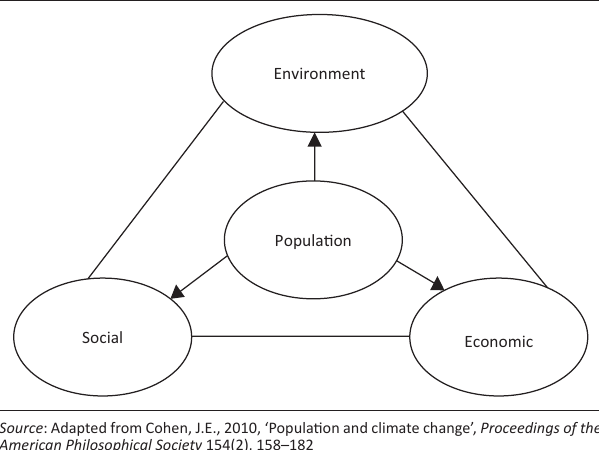
FIGURE 1: Interactions between human population and sustainable development.